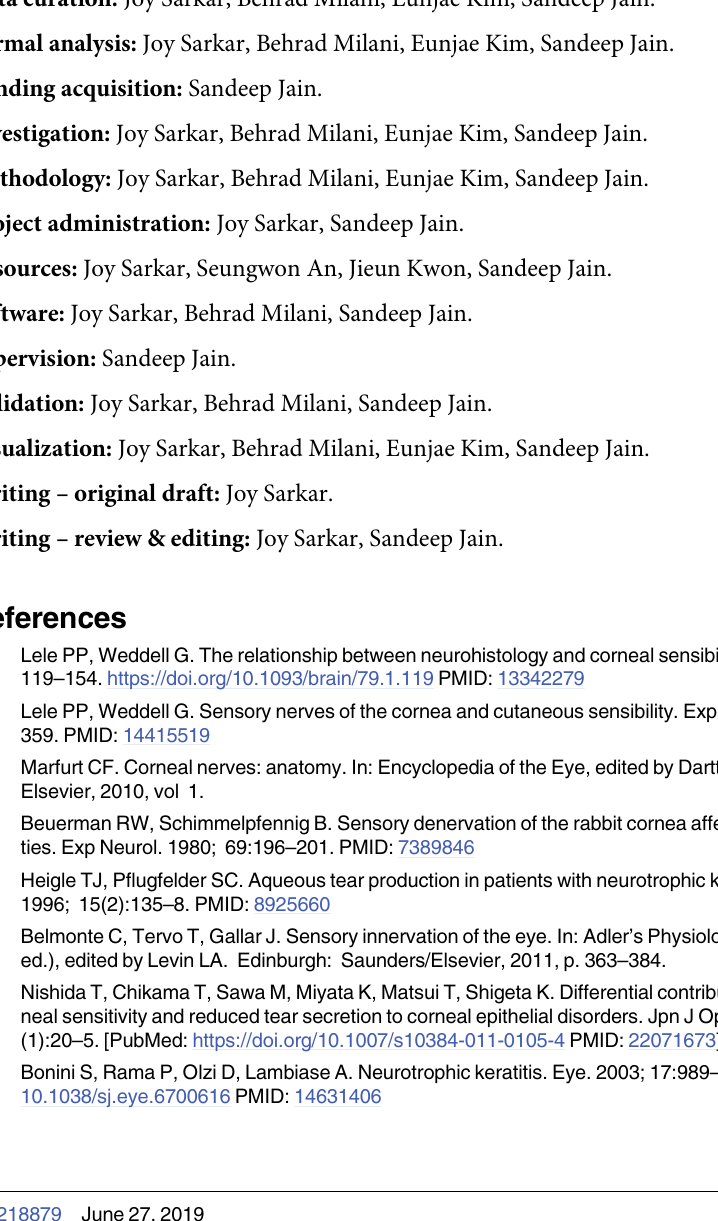
S1 Fig. Corneal Brightfield imaging and fluorescein staining after laser nerve transection. On day 0 before nerve transection, in addition to stereolumar imaging of corneal nerves (A, B), Bright-field image (C) and Fluorescein staining (D) images were taken. Stereofluorescent images were also taken after nerve transection on day 0 (point of transection denoted by a red dot in panel E and red arrow in panels B and F). Bright-field image (G) and fluorescein stain- ing (H) showed absence of superficial punctate keratitis confirming absence of epithelial cell injury. At Day 3, clear, transparent cornea (I) and absence of superficial punctate keratitis (J) confirmed absence of epithelial cell injury after nerve transection; D0 = Day 0; D3 = Day 3.